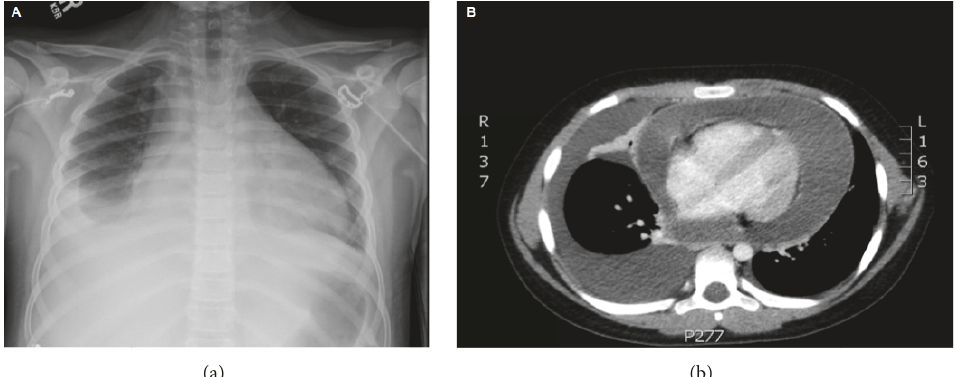
Figure 1: (a) Admission chest X-ray demonstrating enlarged cardiac silhouette with associated right-sided pleural effusion. (b) Computed tomography showing large circumferential pericardial effusion and associated pleural